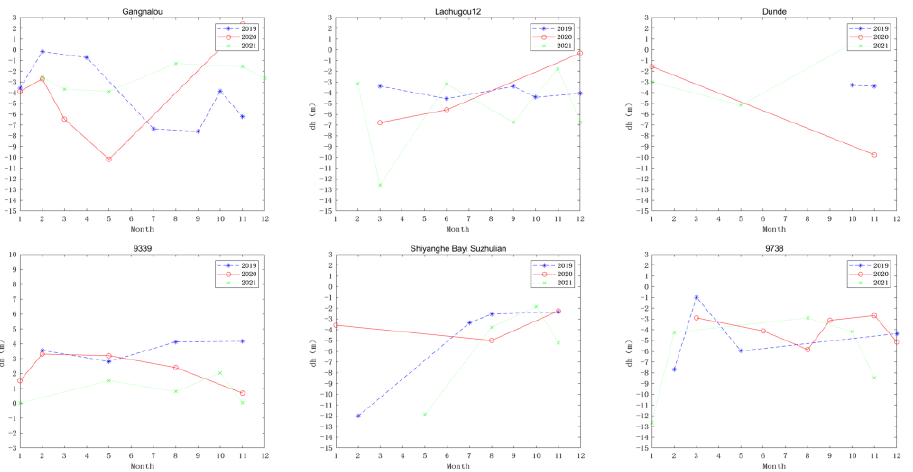
Figure 11. Yearly change in glacier elevation. The blue line is 2019, the red line is 2020, and the green line is 2021. dh is the elevation difference between the current year and 2007. Each point corresponds to the corresponding glacier point in Figure 9, which is the median value of dh.